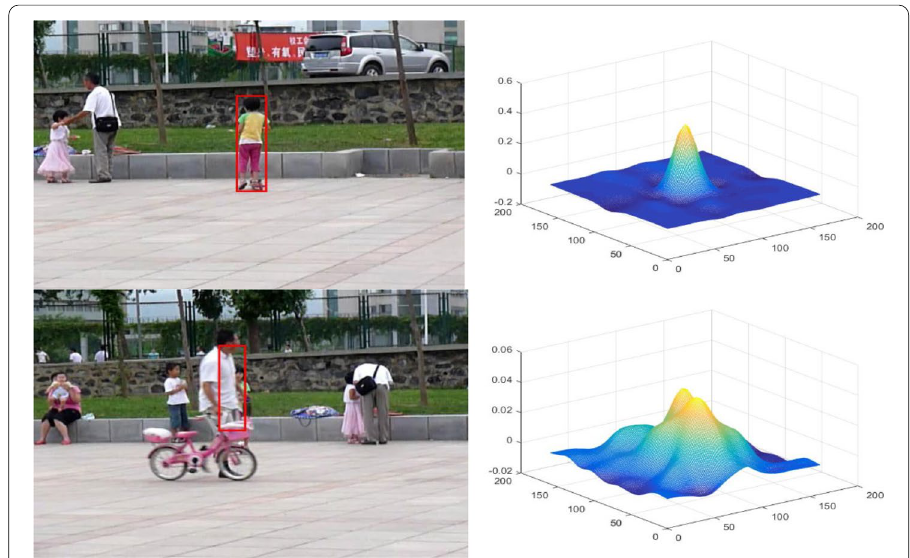
Fig. 3 Results of DCF algorithm for girl2 video sequence and its response